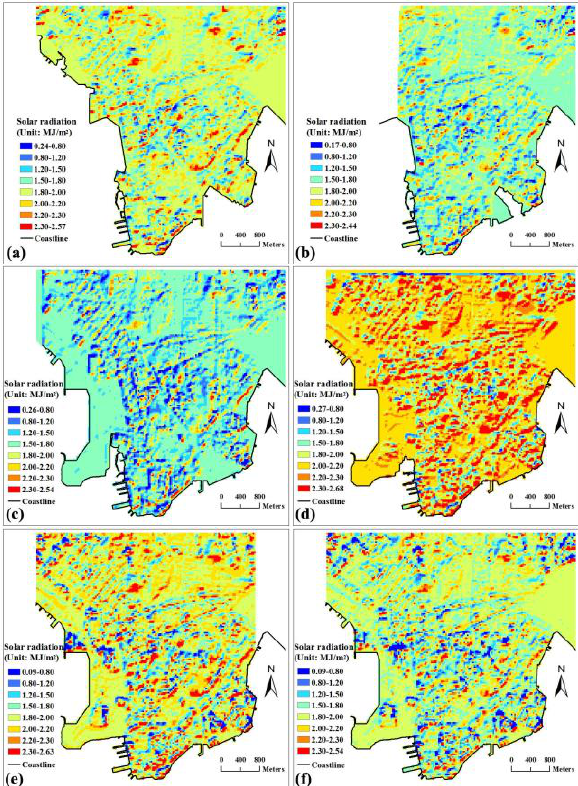
Figure 6. Spatial distribution of GSR at a specific time from 1987 to 2009. (a): 1987; (b): 1990; (c): 1995; (d): 2000; (e): 2005; (f):